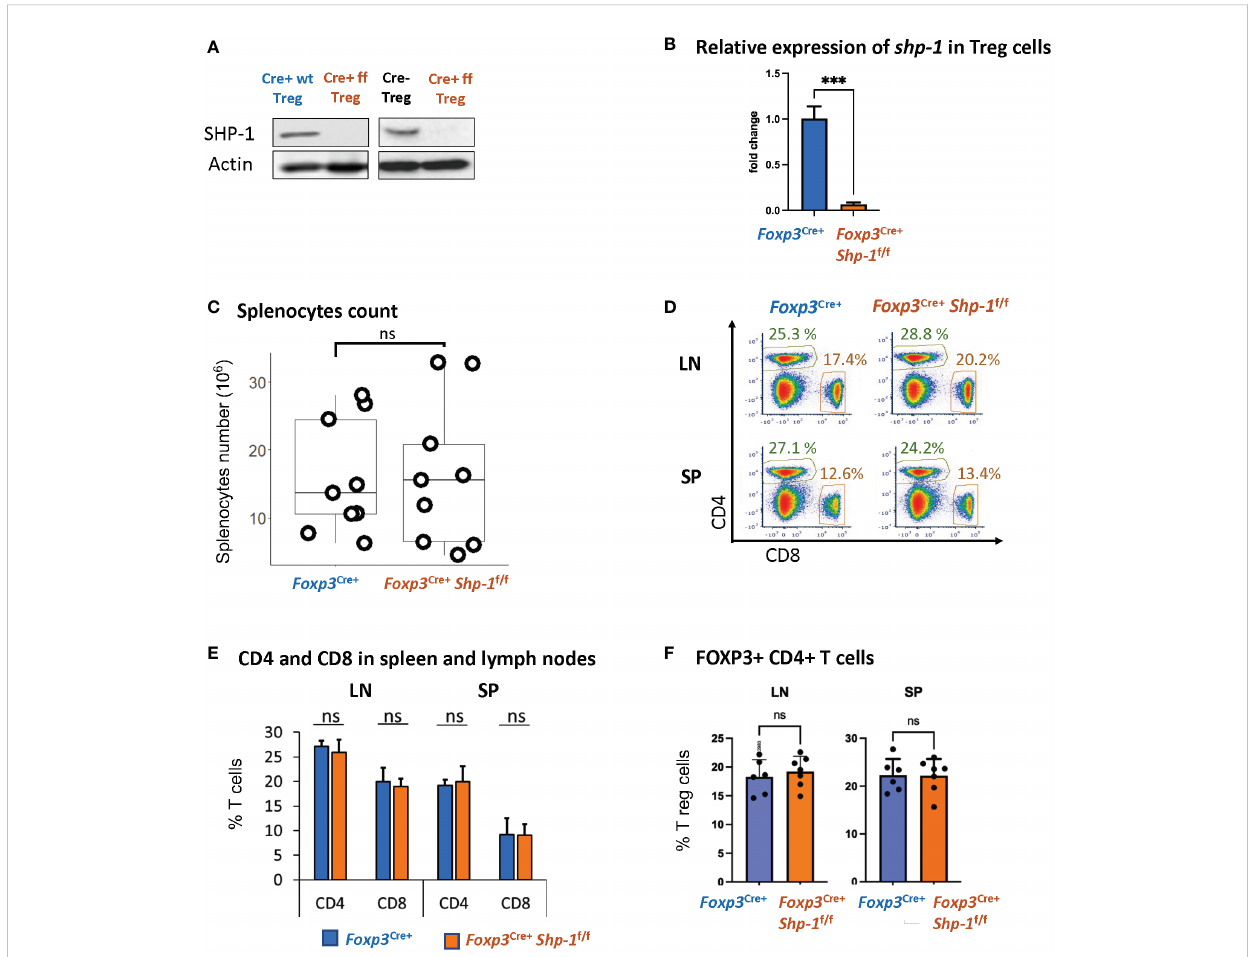
FIGURE 1 Foxp3 Cre+ SHP-1 f/f mice display normal T cell composition . (A) SHP-1 protein levels and (B) relative shp1 mRNA expression levels in isolated CD4+ CD25+ Treg as measured by qPCR. *** p< 0.001 (C) Total numbers of splenocytes isolated from 6-8 weeks mice of indicated genotypes. Data are from 4 independent experiments with each dot representing one animal. ns, not signi fi cant (D) Representative fl ow cytometry data. Percentages of CD4+ and CD8+ subpopulations are indicated. (E) Average percentages of CD4+ and CD8+ T cells in lymph nodes and spleens of mice with indicated genotypes. Data are gated: singlets -> live cells. Data points collected from 5 independent experiments with 6 mice of each genotype. (F) Percentages of Foxp3+ Treg cells within total CD4+ T cells derived from spleens and lymph nodes of mice with indicated genotypes. n=6 for each genotype. Data are gated: singlets → live cells → CD3 → CD4. Each dot representing one